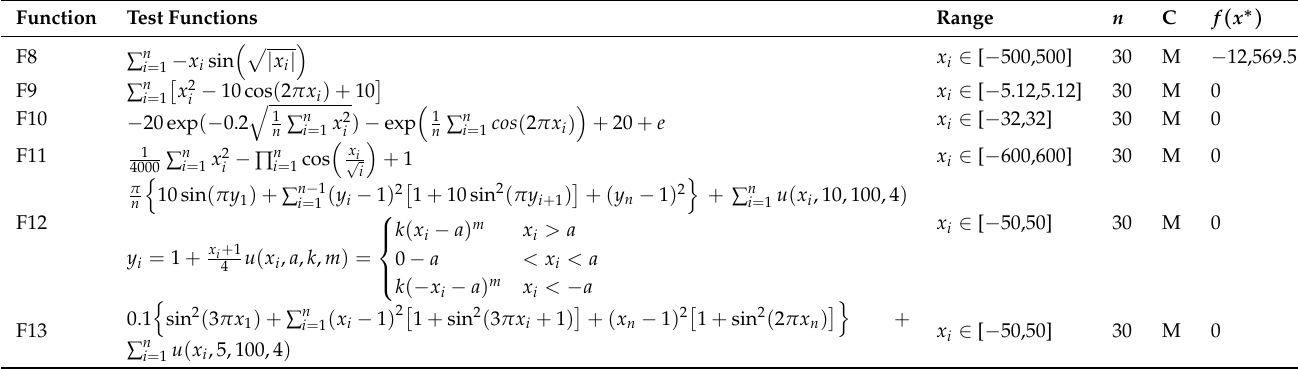
Table 3. The characteristics of multimodal benchmark functions.